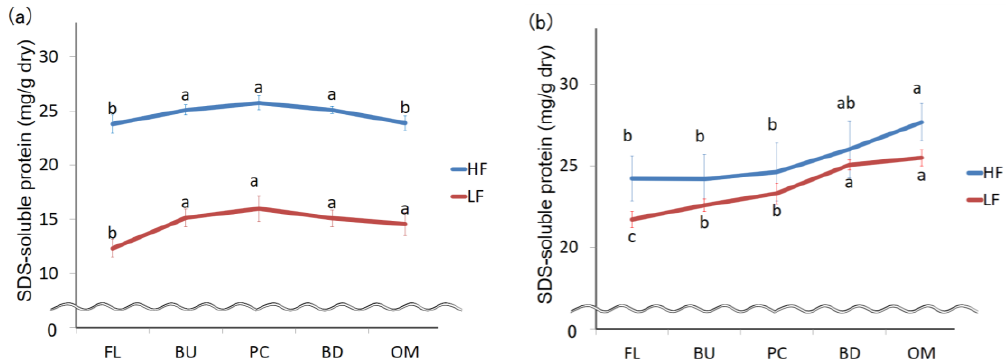
Figure 5. Changes in the amount of protein A aggregates ( a ) and porotein B aggregates ( b ) extracted with 0.5% SDS during mixing. FL, BU, PC, BD and OM indicate flour (before mixing), build up, peak consistency, breakdown and overmixing, respectively. HF and LF mean high protein flour and low protein flour. The error bars show standard deviations ( n = 6). Different letters on the graphs indicate significant differences ( p < 0.05).